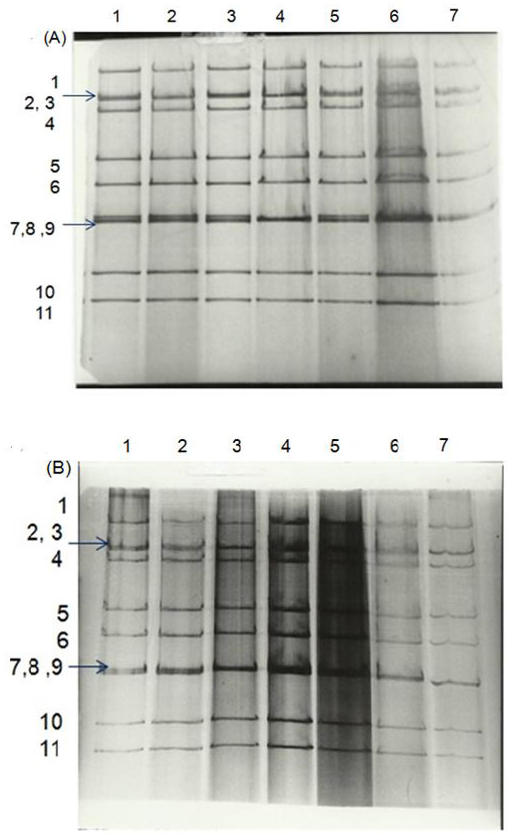
Figure 4. Electrophoretic profile of the rotavirus genome detected in herds of the State of São Paulo. (A) Trough 1, 2, 3, 5, 6 (profile C); 4 (profile F); 7 standard (NCDV); (B) Channels 1, 2, 4 and 5 (profile A); 3, 6 and 7 (profile G); 7 standard